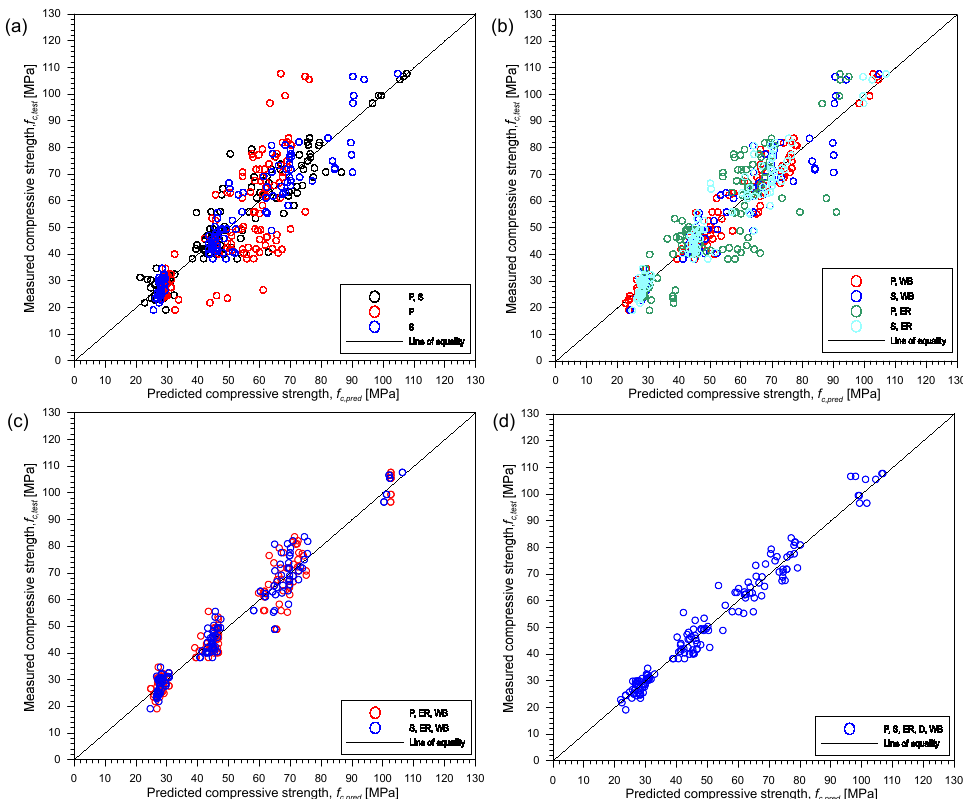
Figure 12. Correlation between actual f c,test and predicted f c,pred using different combinations of the five parameters from Gaussian process regression analysis. ( a ) only UPV parameters: P, S, or P and S, ( b ) combination of UPV and one other parameter: P and WB, S and WB, P and ER or S and ER, ( c ) combination of UPV, ER and WB: P, ER and WB or S, ER and WB and ( d ) five all parameters: P, S, ER, D and WB. Note S is S-wave velocity, P is P-wave velocity, ER is electric resistivity, D is density and WB is water-to-binder ratio. Table 9. Coefficient of determination values (R-squared values, R 2 ) of training results from regres- sion learner training.